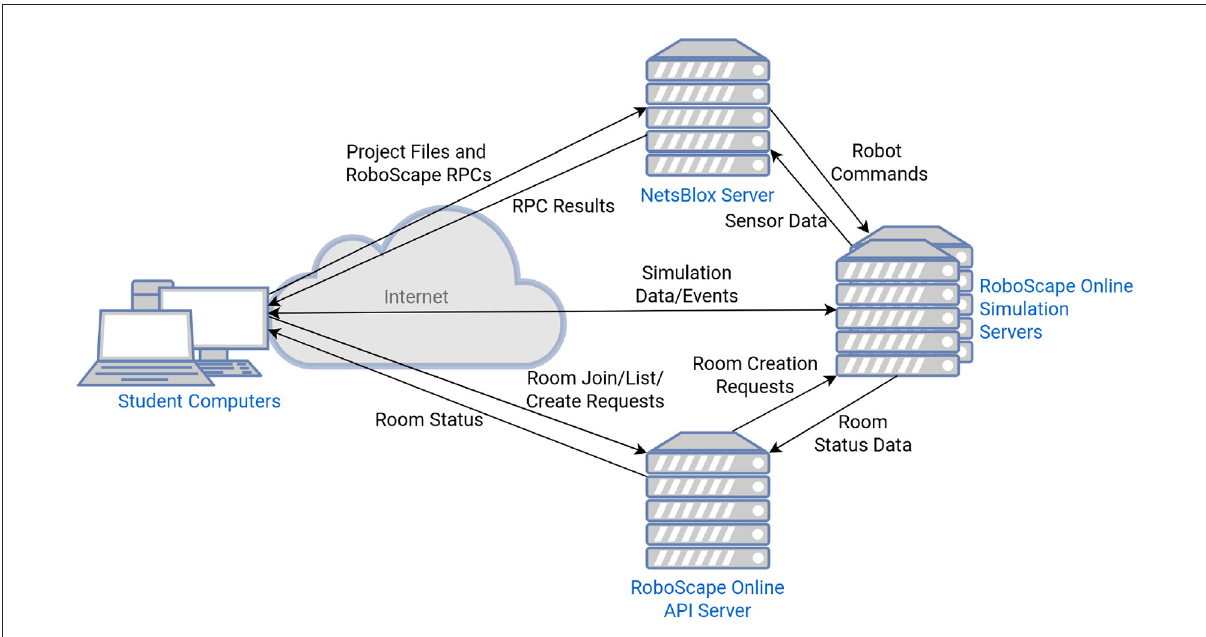
FIGURE7 Architecture of RoboScape Online